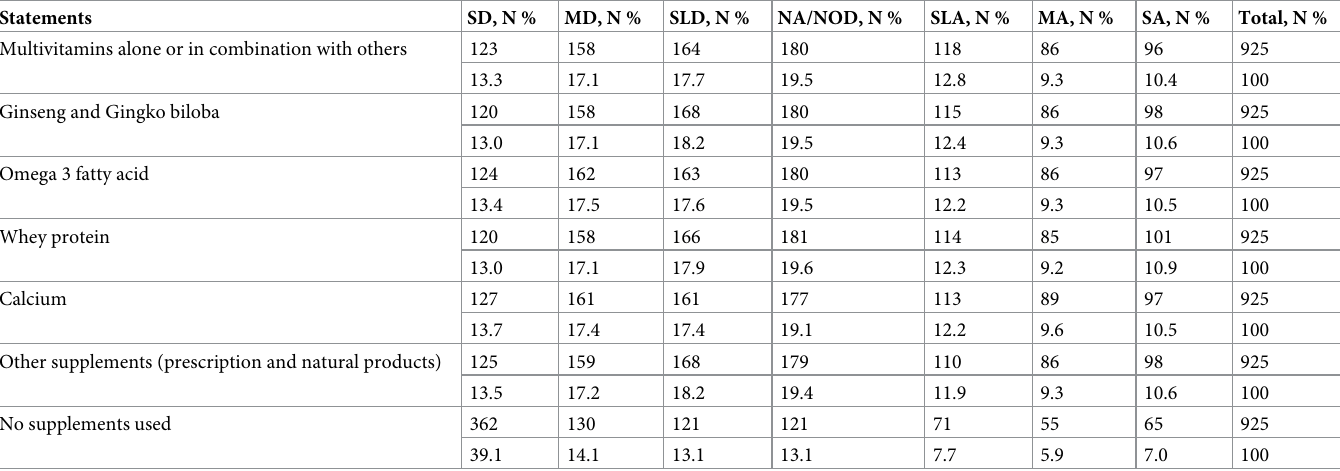
Table 4. Types of dietary supplement used.